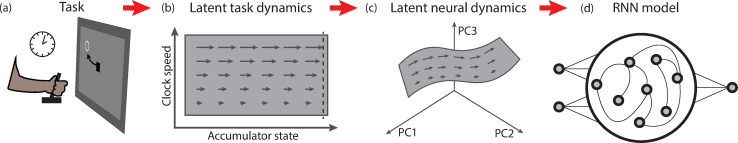
Embedding latent task dynamics into recurrent neural networks.a) A hypothetical task, adapted from [27]. The subject is instructed to produce a time interval by making a delayed movement. b) Latent task space over a manifold (gray rectangle) based on a clock-accumulator model [28]. The y-value reflects the speed of the clock, and the x-value reflects the state of the accumulator before movement initiation. In this model, the instruction sets the speed of the clock (length of the arrow) at which the accumulator evolves over time (faster for shorter intervals). Movement is initiated when the accumulator reaches a threshold (dashed line). c) A nonlinear embedding of the task manifold depicted in a neural state space spanned by the first three principal components of population activity. d) An RNN model to establish the desired nonlinear embedding.